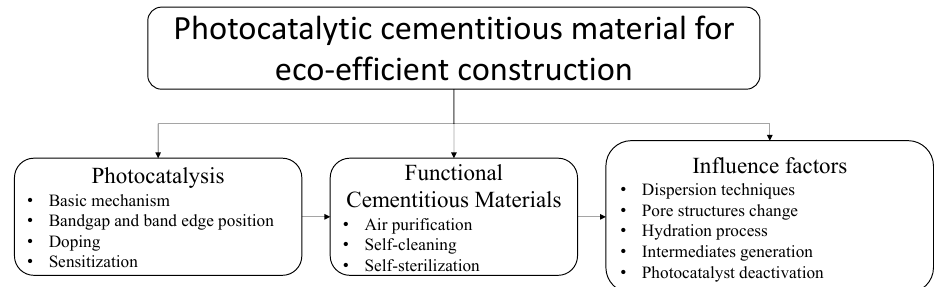
Figure 2. Review frame of photocatalytic cementitious material for eco-efficient construction.